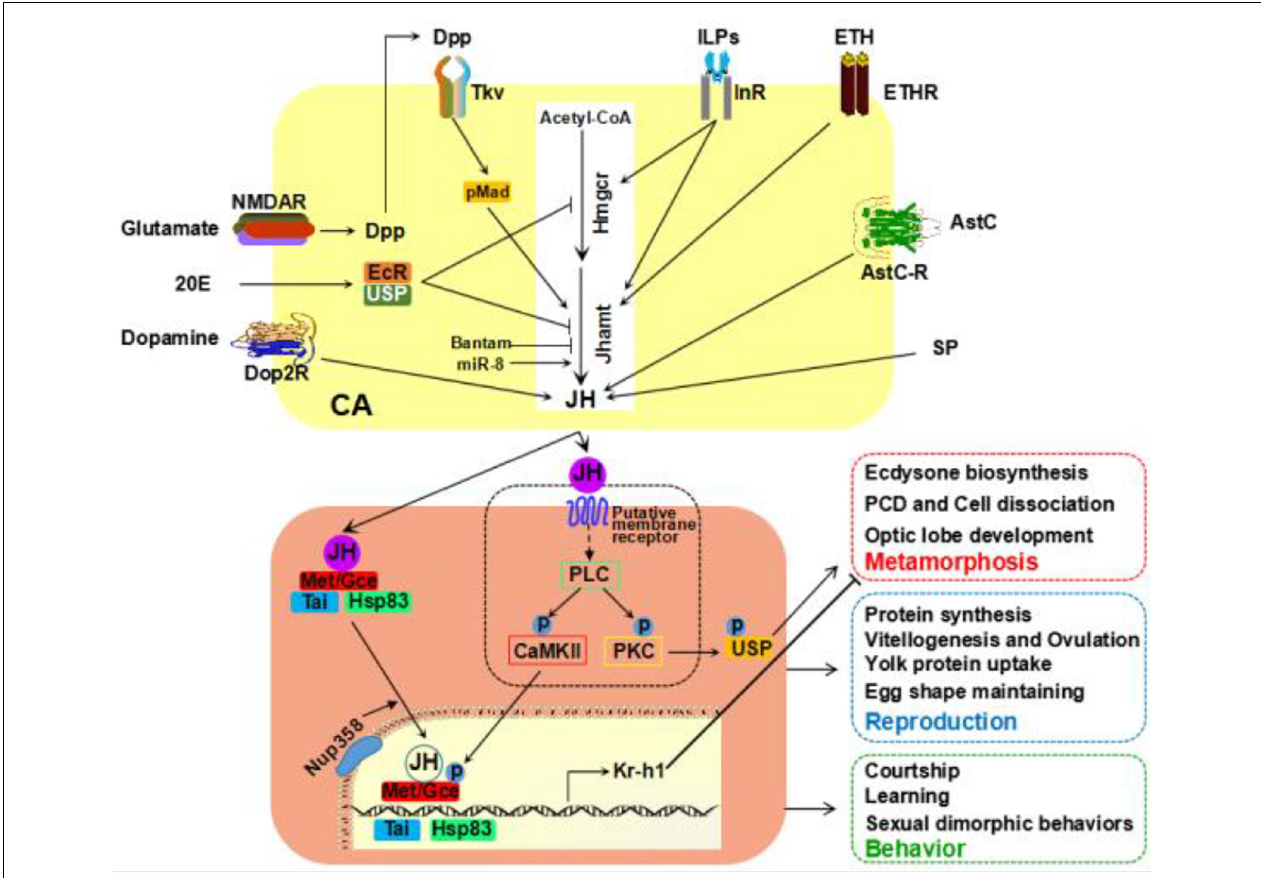
FIGURE 1 | Recent studies on JH studies in Drosophila . Examples of various factors affecting JH biosynthesis in corpus allatum (CA) cells at the larval or adult stage. JH employees both intracellular and membrane receptors for signal transduction. JH signaling plays an essential role in multiple physiological processes. JH, juvenile